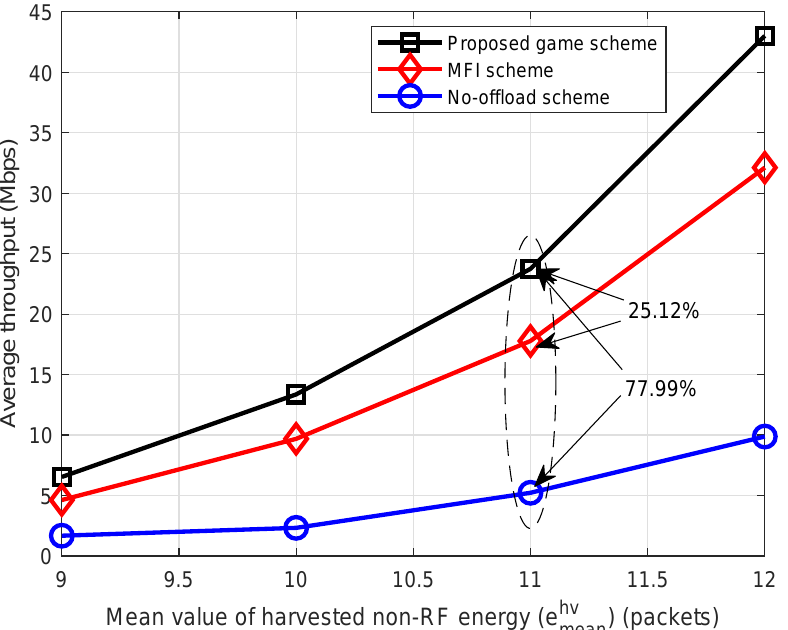
Figure 4. The influence of mean harvested non-RF energy on average throughput of the network when mean value of harvested non-RF energy is changed from 9 to 12